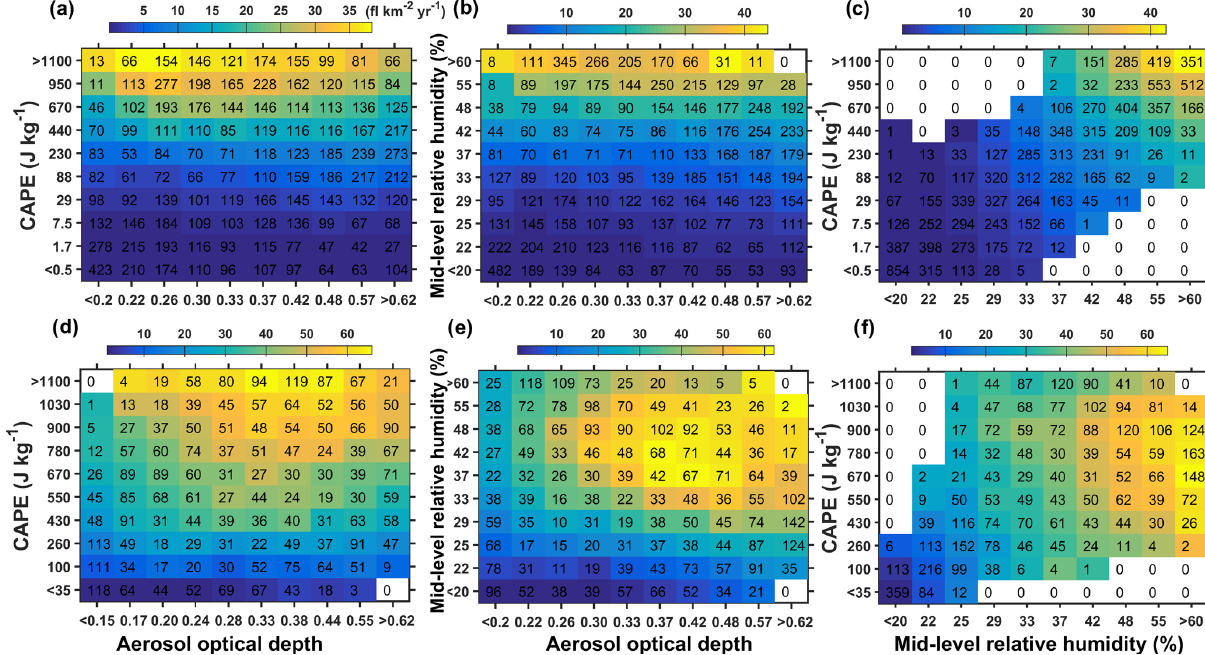
Figure 10. Joint dependence of the lightning flash rate on CAPE, mid-level relative humidity, and aerosol optical depth in the dust- (a–c) and smoke-dominant (d–f) regions. The bold number in each cell indicates the number of samples in the cell. The color bar denotes the number of lightning flash rates averaged in each